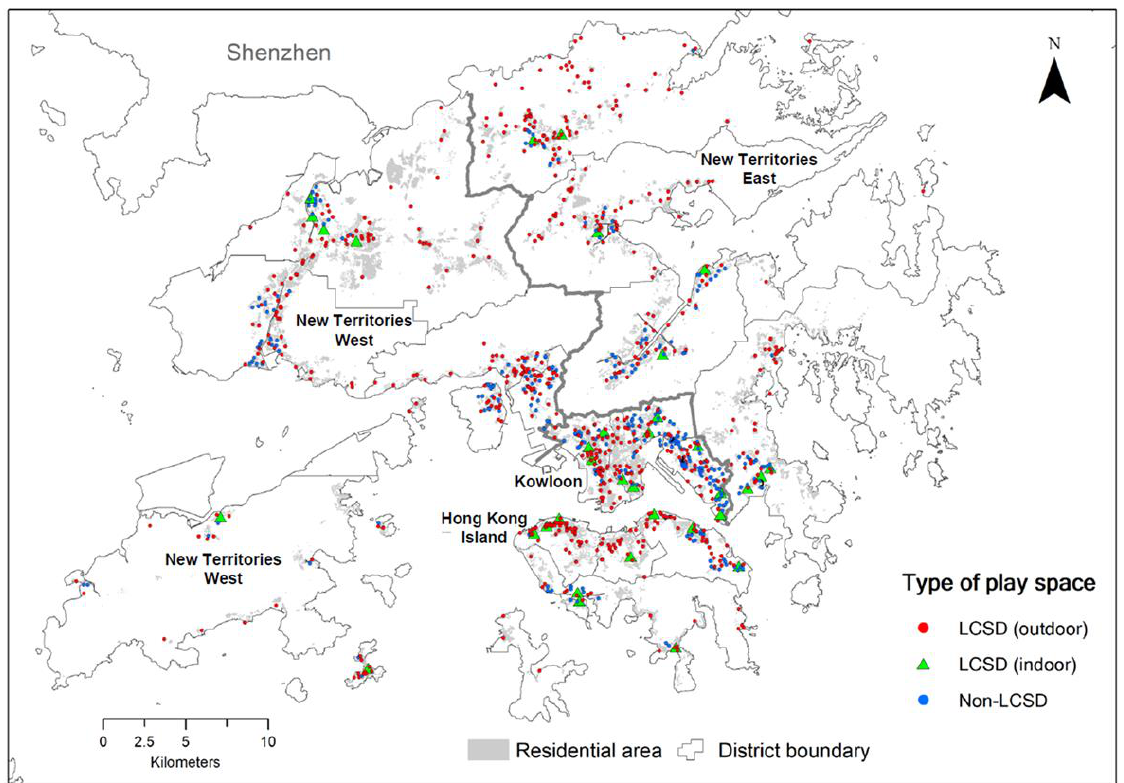
Figure 1. Locations of public play spaces in Hong Kong, 2016.